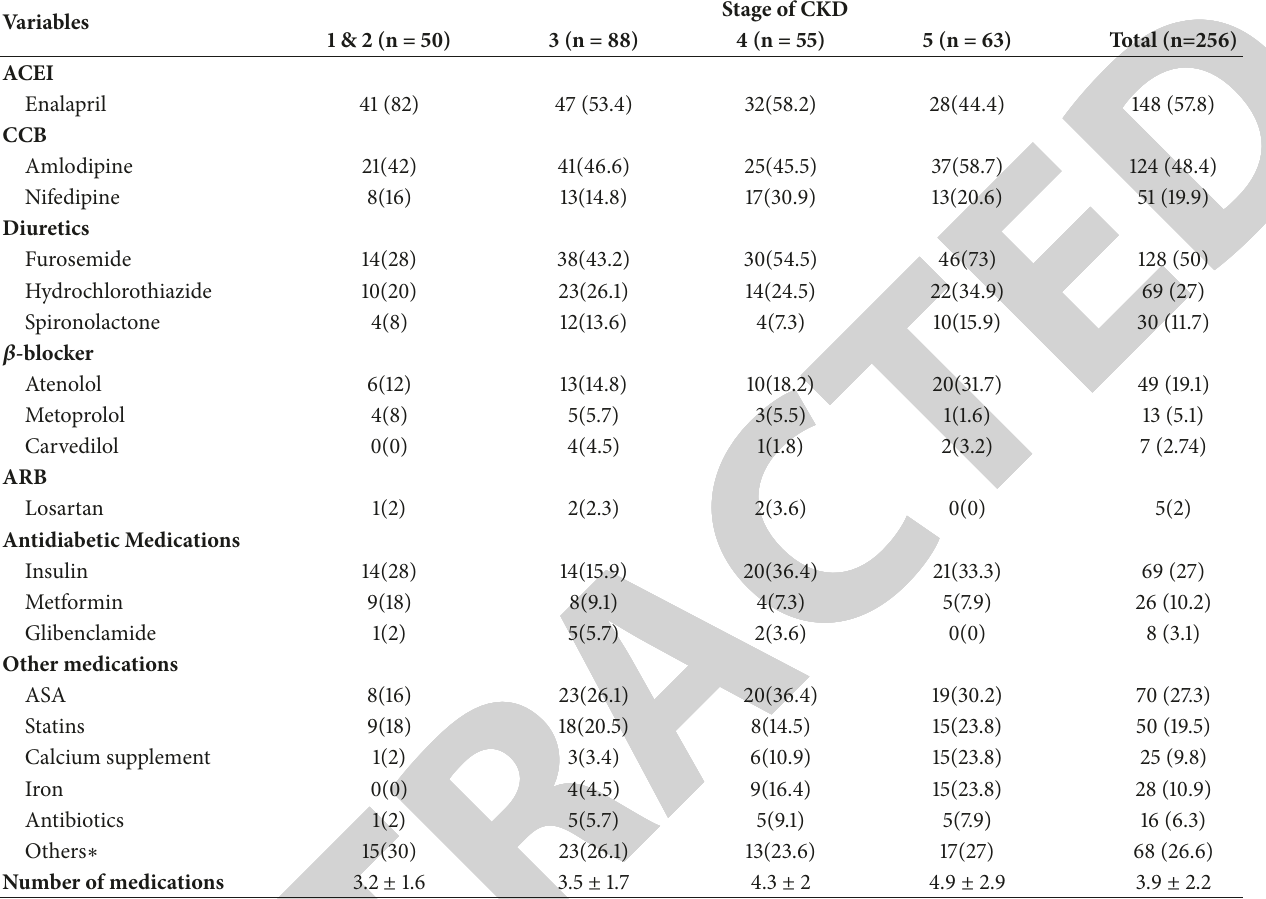
Table 5: Profile of prescribed medications for chronic kidney disease patients attending the renal clinic of Tikur Anbessa Specialized Hospital.